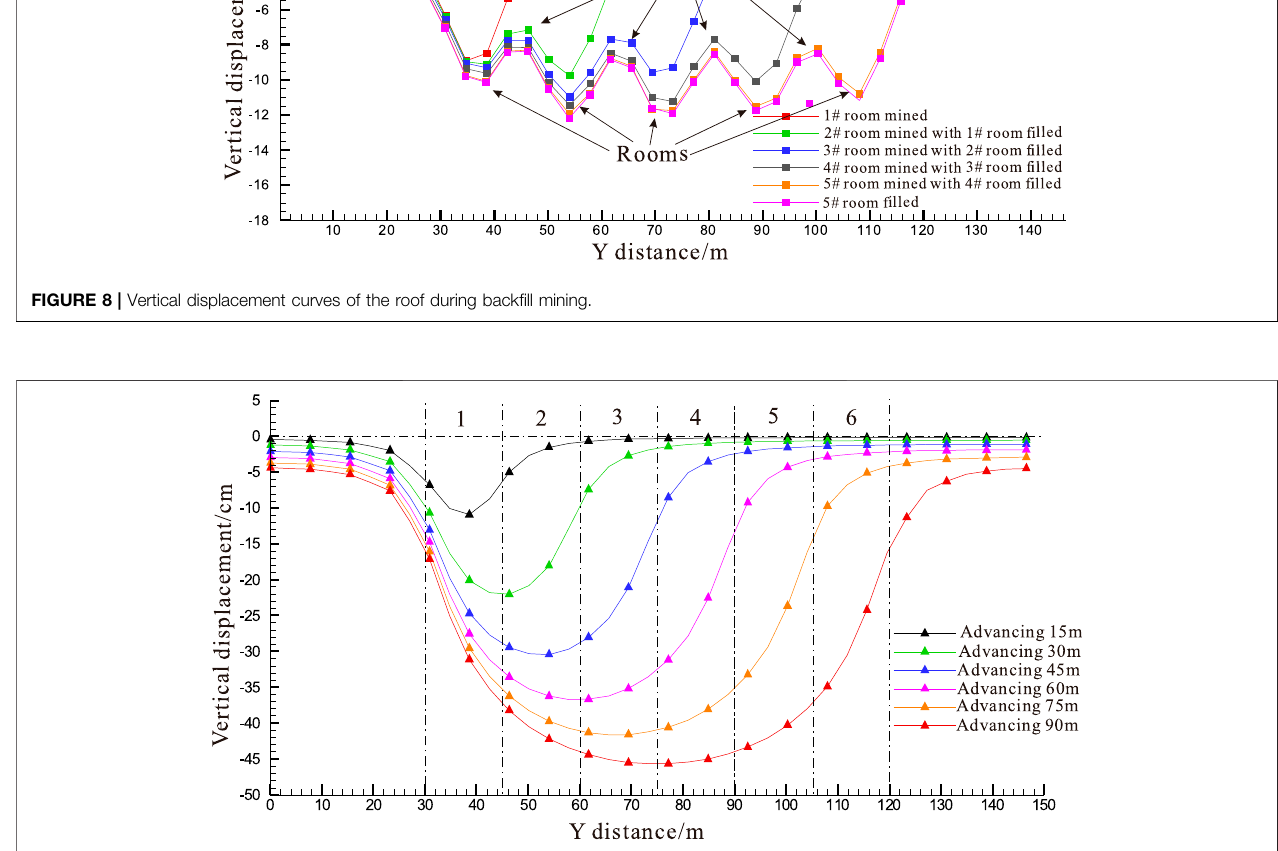
FIGURE 9 | Vertical displacement curves of the roof at different advance